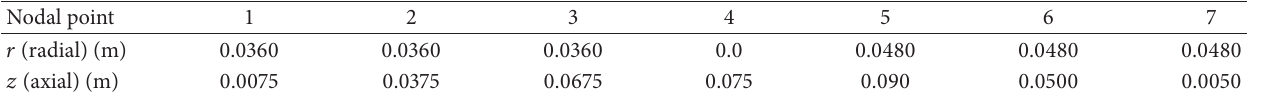
Table 2: Nodal points with coordinates.